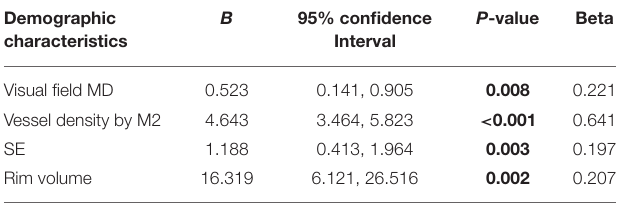
TABLE 2 | Intraclass correlation coefficients of two quantitative methods.